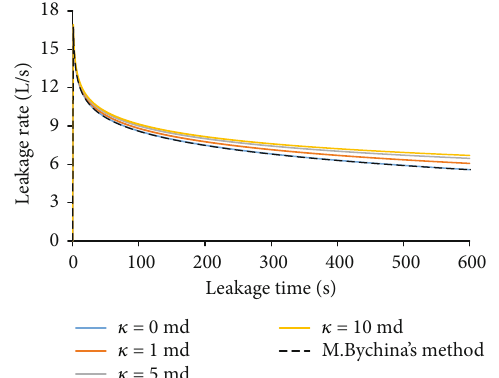
Figure 8: Leakage rate graph under di ff erent formation permeability.